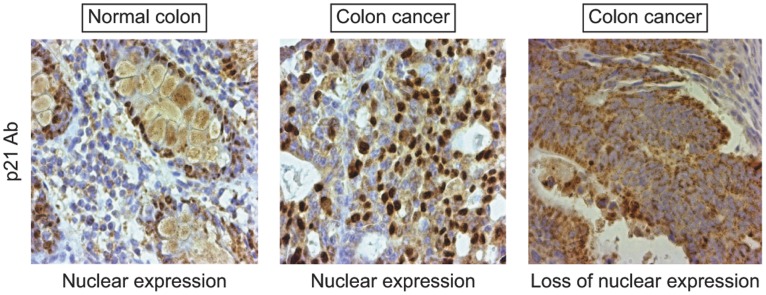
Expression of p21 is lost in a subset of primary colon cancers correlating with the ACVR2/TGFBR2 receptor status.Fifty-six colon cancers were stained for ACVR2, TGFBR2 and p21. Representative examples for p21 staining are shown: normal colon tissue with nuclear staining (left panel), colon cancer sample with maintained nuclear p21 staining (middle panel), and colon cancer sample with loss of nuclear p21 staining (right panel).